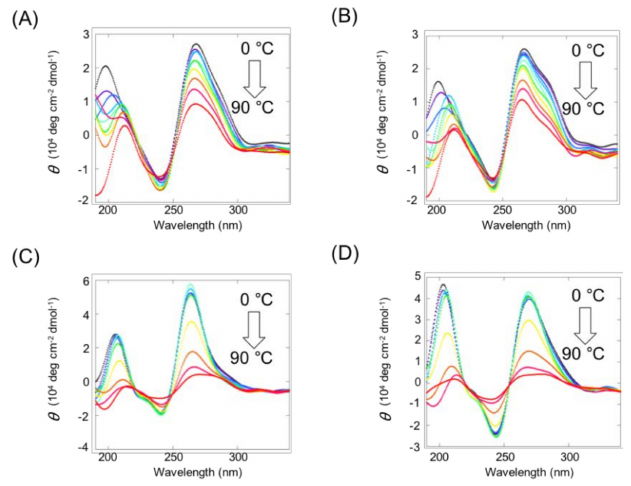
Figure 4. CD spectra of 10 µ M VEGF G2T with 10 µ M ( A ) BPEAG 3 , ( B ) G 3 BPEA, ( C ) PerG 3 , and ( D ) G 3 Per. All the experiments were conducted in a buffer consisting of 10 mM Tris-HCl (pH 7.5), 8 mM MgCl 2 , and 50 mM KCl.